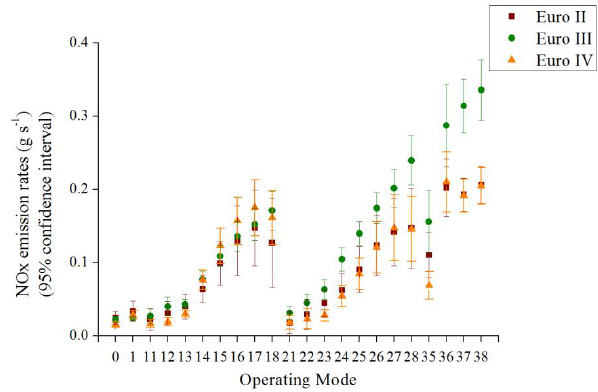
Fig. 1. Summary of average NO X emission rates for Euro II, Euro III and Euro IV buses by operating mode.